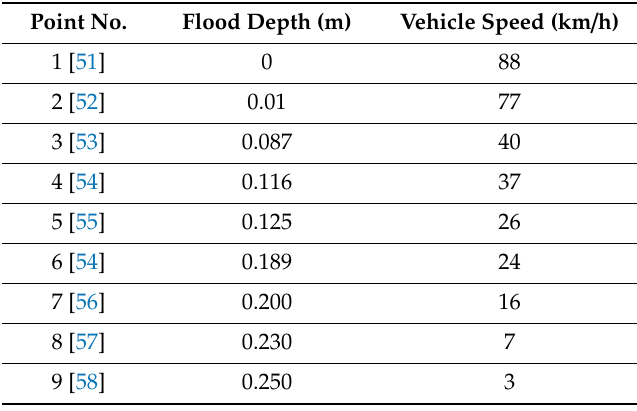
Table 1. Speed reduction caused by rainfall from previous